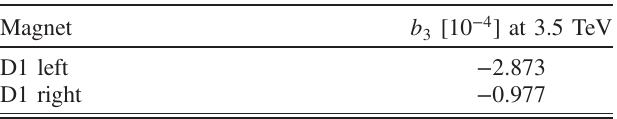
TABLE II. Verified b 3 components of the D1 separation dipoles left and right of IP2 at 3.5 TeV. The quoted multipole coefficients are values relative to the main dipole field, in units of ½ 10 − 4 (cid:5) , at a reference radius of 0.017 m.